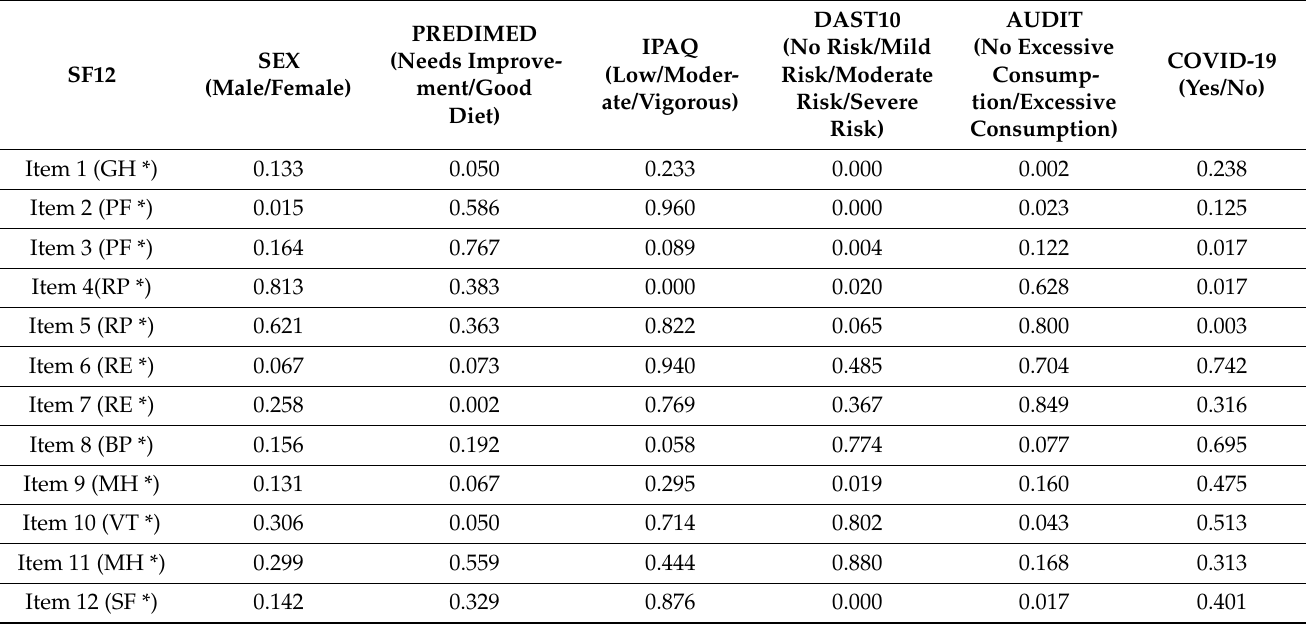
Table 4. p -values for SF12 questionnaire by sex, COVID-19 disease and eating habits, alcohol and drug consumption, and physical